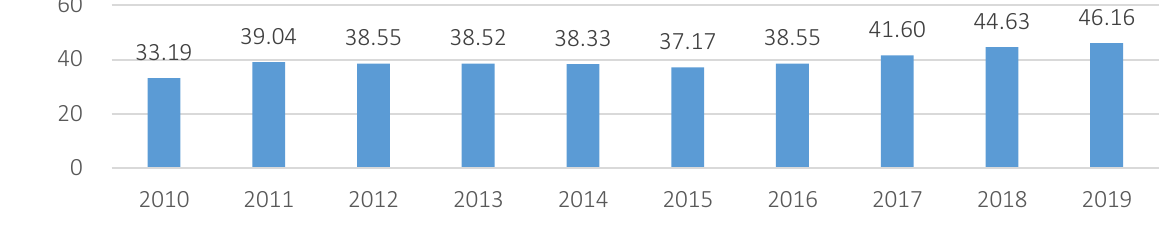
Figure 4. Thailand’s export of goods to China from 2010 to